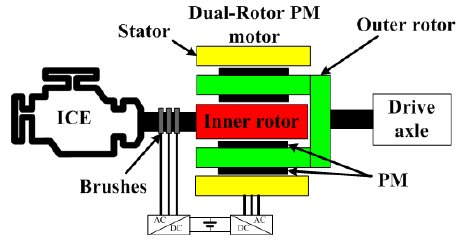
Figure 20. Dual-rotor PM electric continuously-variable transmission (ECVT).